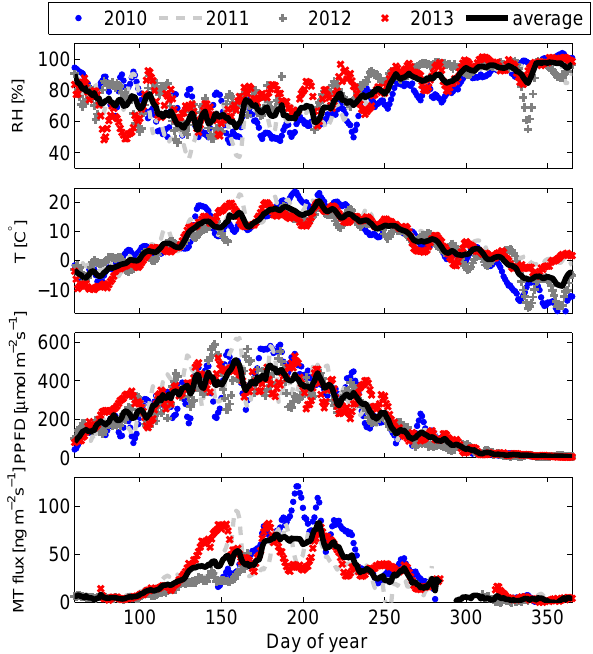
Figure 2. Five-day running averages of relative humidity (RH), temperature ( T ), PPFD, and gap-filled monoterpene flux (MT flux) for each year as a function of day of year (days 60–365). The thick black solid lines represent averages calculated from the 5-day run- ning